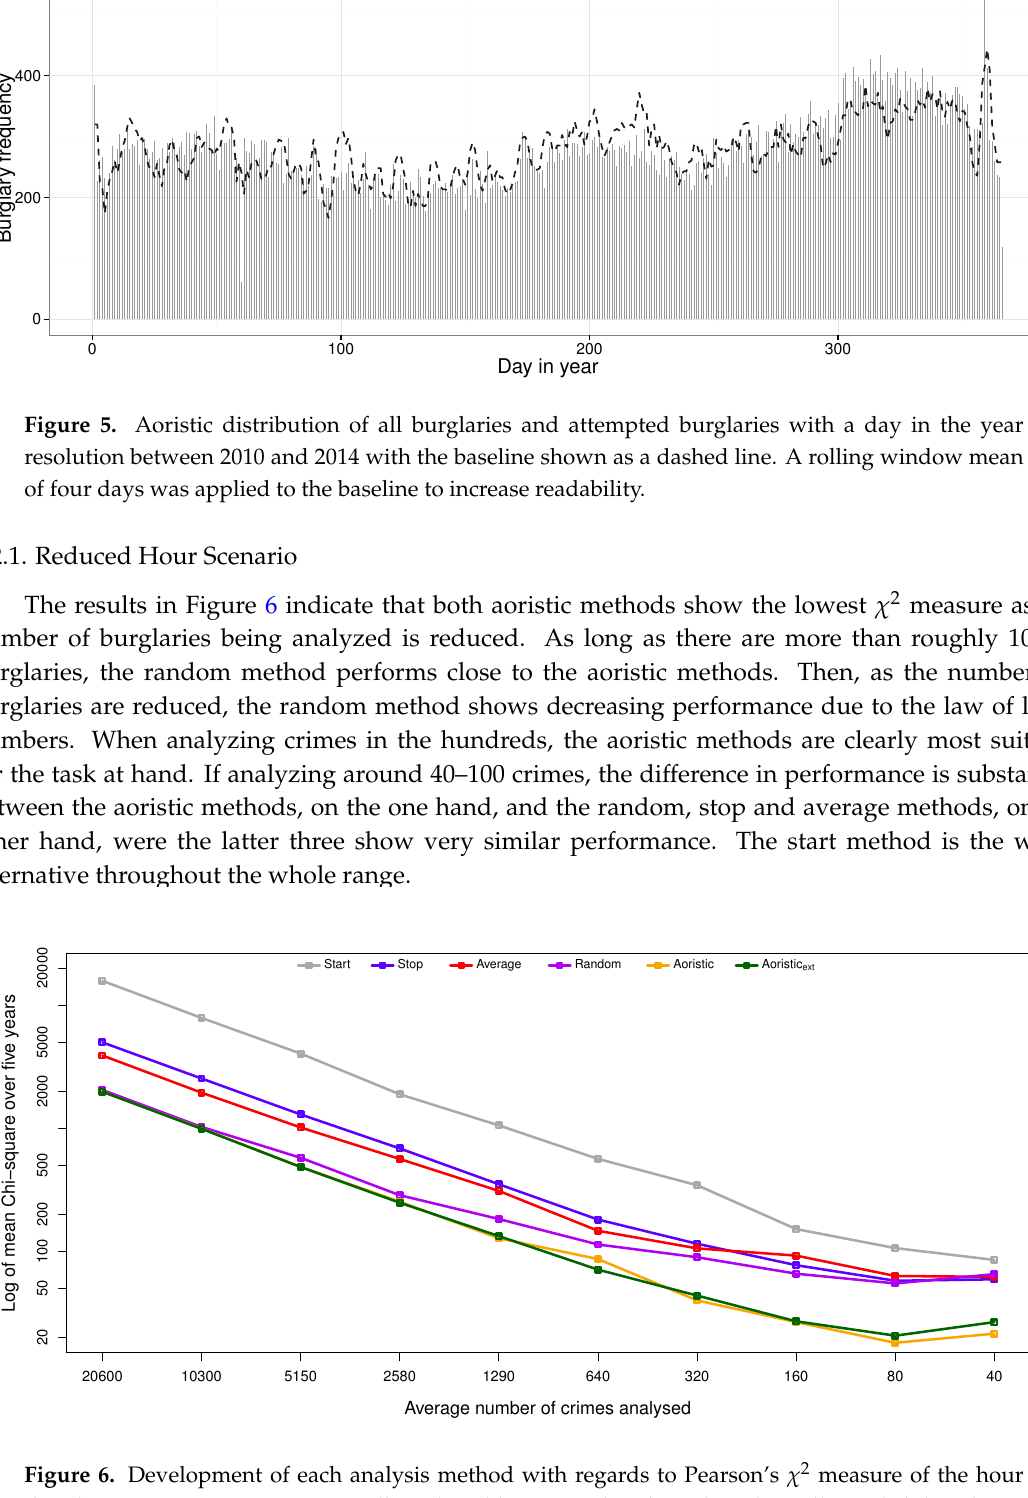
Figure 6. Development of each analysis method with regards to Pearson’s χ 2 measure of the hour distributions as crimes are repeatedly reduced by 50%. The plot is based on all Swedish burglaries between 2010 and 2014 (N =